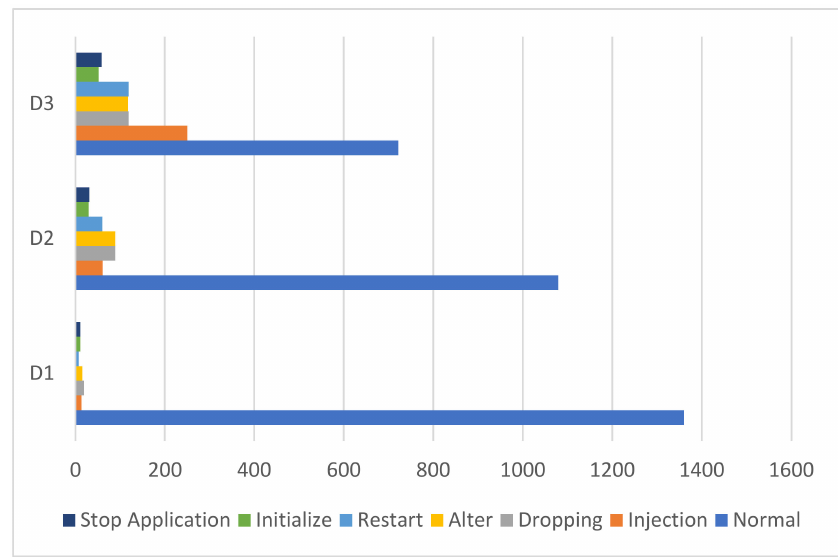
Figure 11. Attack distributions of datasets D1, D2, D3.